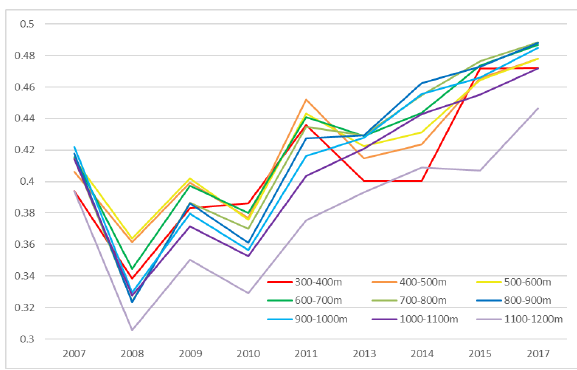
Figure 7. Broken-line graph showing EVI changes from 2007 to 2017 in different elevation zones.